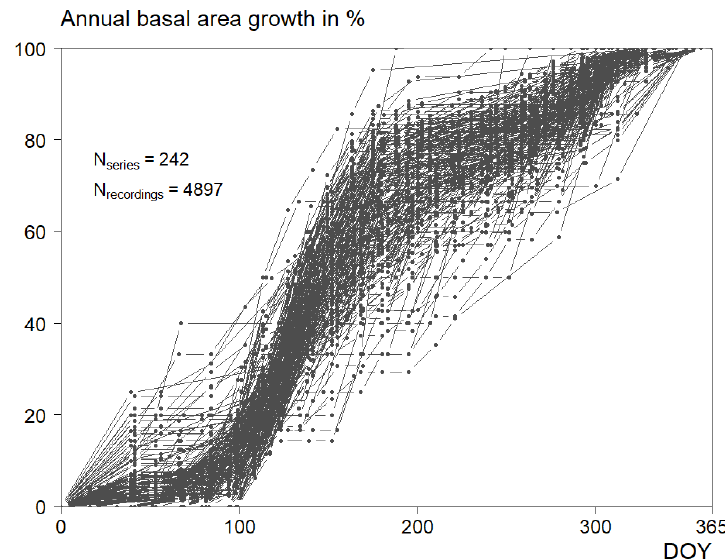
Figure 4. The intra ‐ annual basal area growth pattern of all 242 time series. On average, 25% of the total annual basal area growth was achieved on 25th April ( DOY = 115), 50% on 1st June ( DOY = 152) and 75% on 28th August ( DOY = 213). Variation increased from 15 days for RelBA25 to 37 days for RelBA75 (Figure 5).